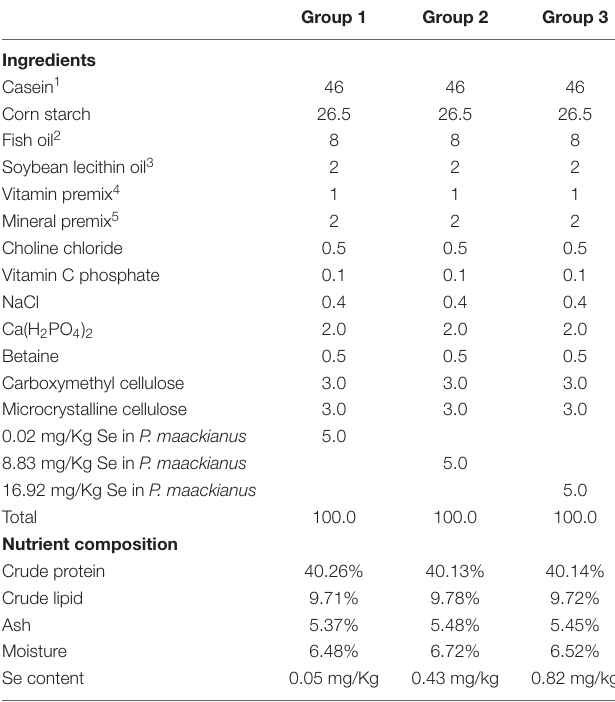
TABLE 1 | Ingredients and proximate composition of experimental